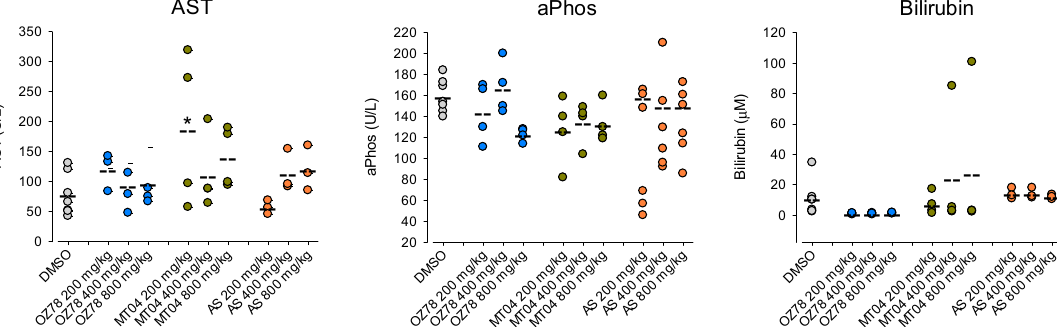
Figure 6. E ff ect of AS, OZ78, and MT04 on the activity of aspartate aminotransferase (AST) and alkaline phosphatase (aPhos) and on the serum bilirubin concentration. AST, aPhos, and total serum bilirubin were analyzed in plasma from mice treated with single doses of 200, 400, and 800 mg / kg of AS, OZ78 or MT04 or vehicle control (DMSO). Blood was obtained 8 hours after oral administration. Each data point in the graph corresponds to one mouse. The mean of each group is indicated. * p < 0.05 vs. respective control group